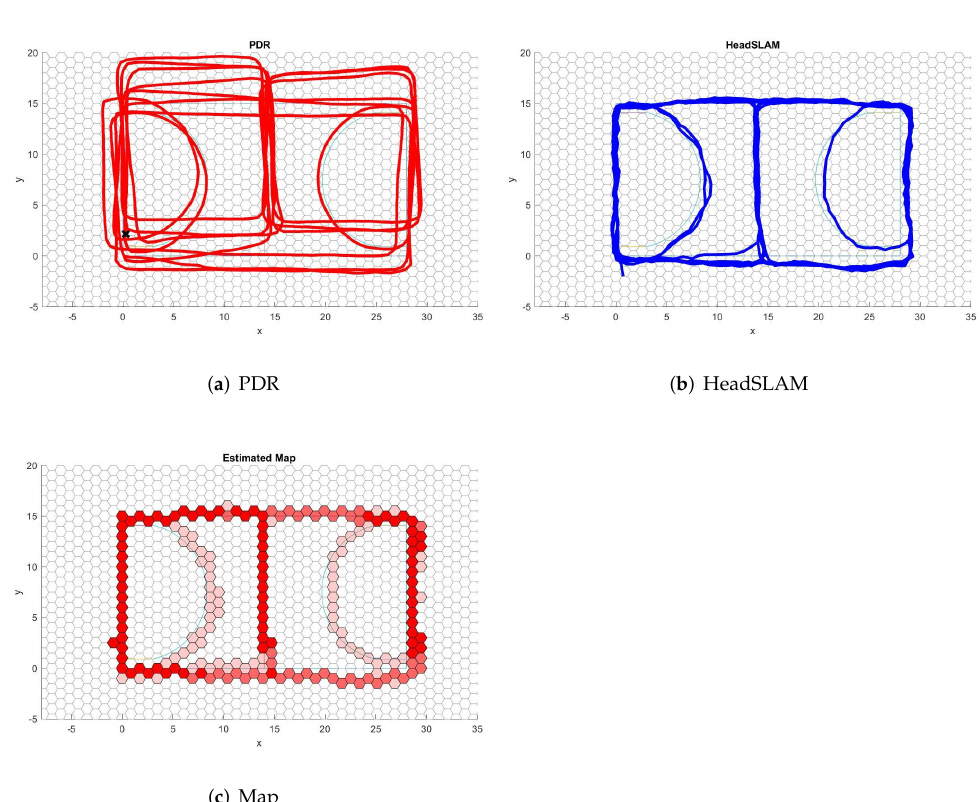
Figure 5. Outdoor test results’ example. Participants were asked to walk the outline of a basketball court. Red lines in ( a ) represent the trajectory estimated by the PDR method. Blue lines in ( b ) show the trajectory of the particle with the highest weight in SLAM. Red hexagons in ( c ) represent the trajectory map generated by HeadSLAM, with darker shades representing those with a higher visiting frequency.